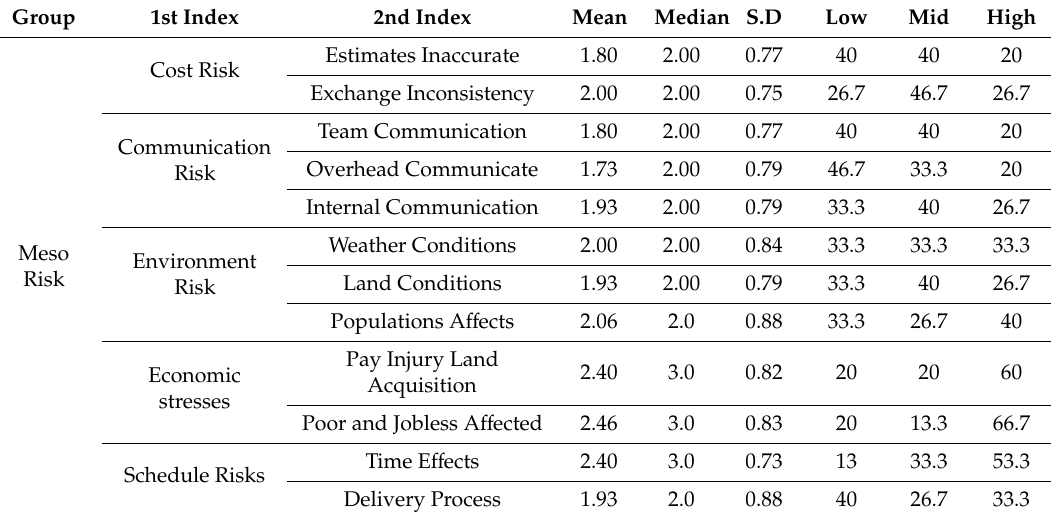
Table 7. Meso-level risk for round